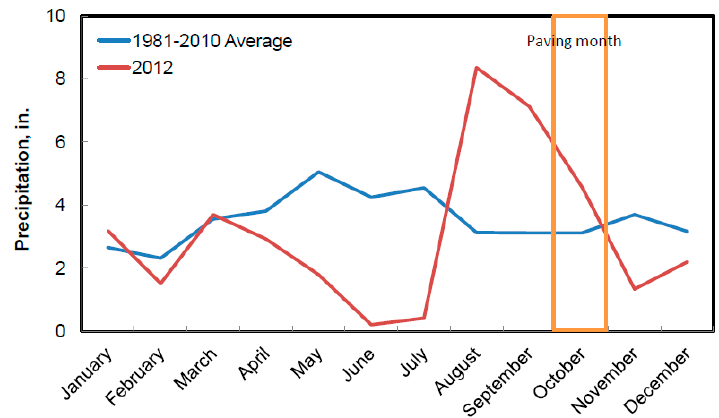
Figure 8. Comparison of monthly precipitations. .